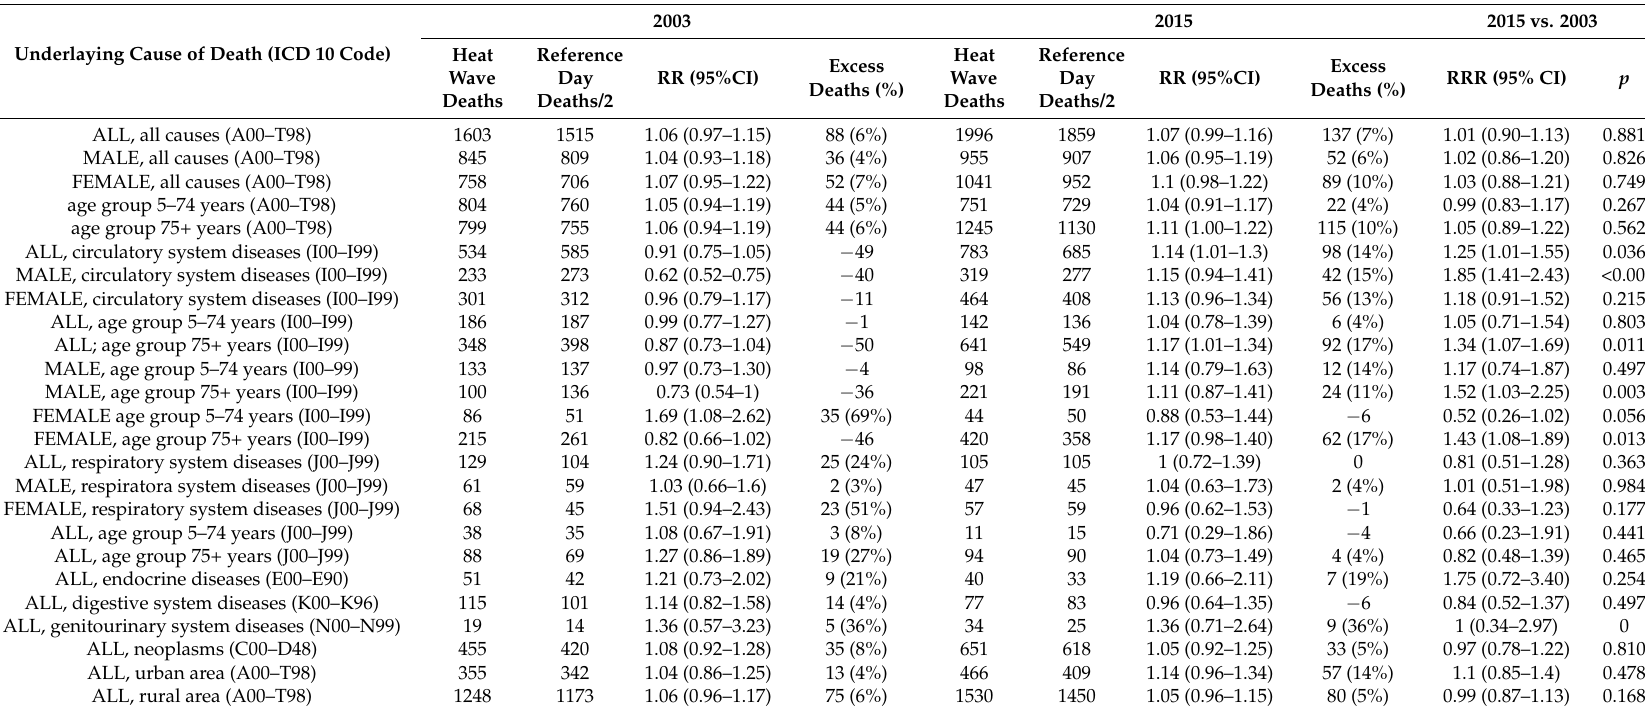
Table 2. Relative risks (RR) for death during heat waves, 95% confidence intervals (95% CI) and excess deaths by the observed diagnosis, sex, age groups, and area for 2015 and 2013, and relative risks ratio (RRR), 95% confidence intervals (95% CI) and p -value for comparing association between 2015 and 2003 for